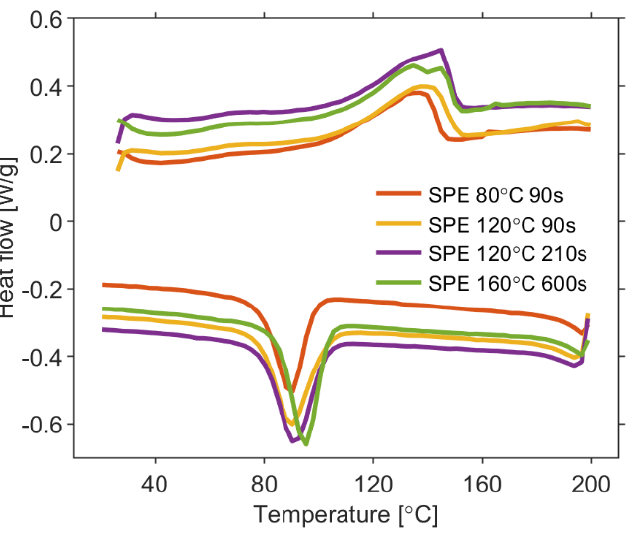
Figure 5. DSC thermogram of PVDF/NMP/[EMIM][TFSI] electrolytes of four treatment conditions. Assuming pure PVDF to be 100%, the relative crystallinity, γ c , is determined by for- mula [65]